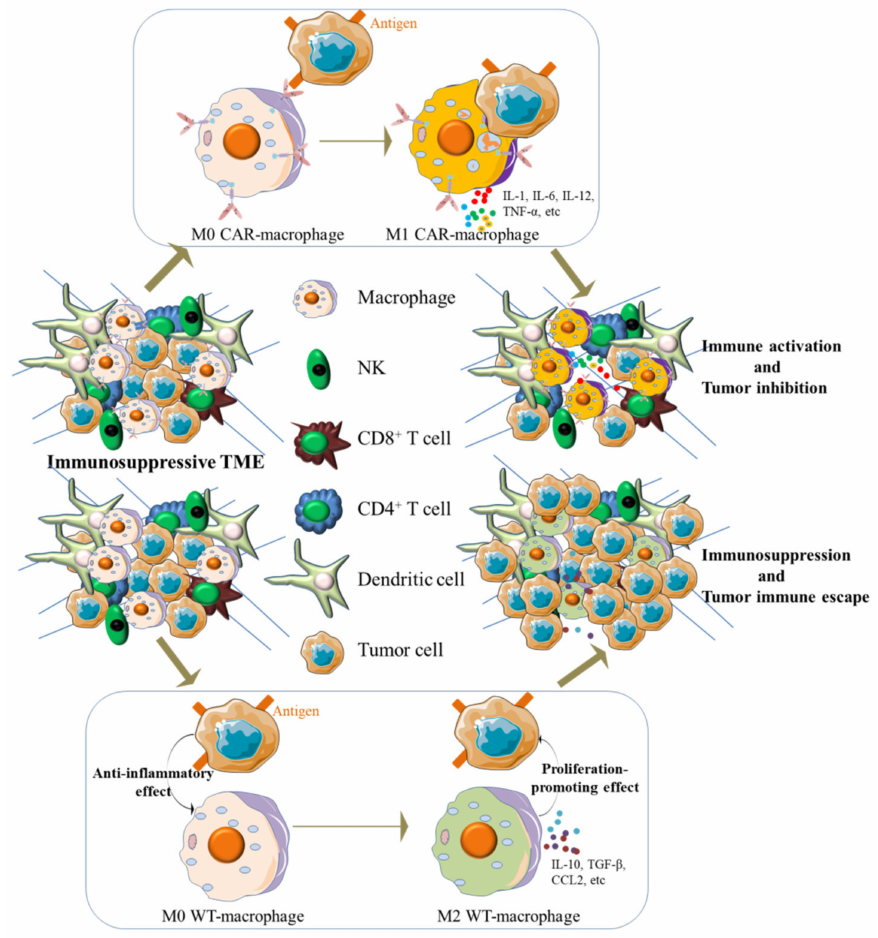
Figure 2. CAR-macrophages exert antigen-dependent cytotoxic activity against antigen-expressing tumor cells in vivo and contribute to the change of TME. When exposed to the surface antigen of tumor cells, M0 state CAR-macrophages switched into a pro-inflammatory phenotype (M1) and exerted an antitumor effect. Meanwhile, activated CAR-macrophages reprogramed the TME by releasing pro-inflammatory cytokines that can activate innate immune cells in TME, such as exhausted CD8 + T cells, while adoptive transplanted WT-macrophages will be induced into an immunosuppressive state (M2) and therefore orchestrated an immunosuppressive